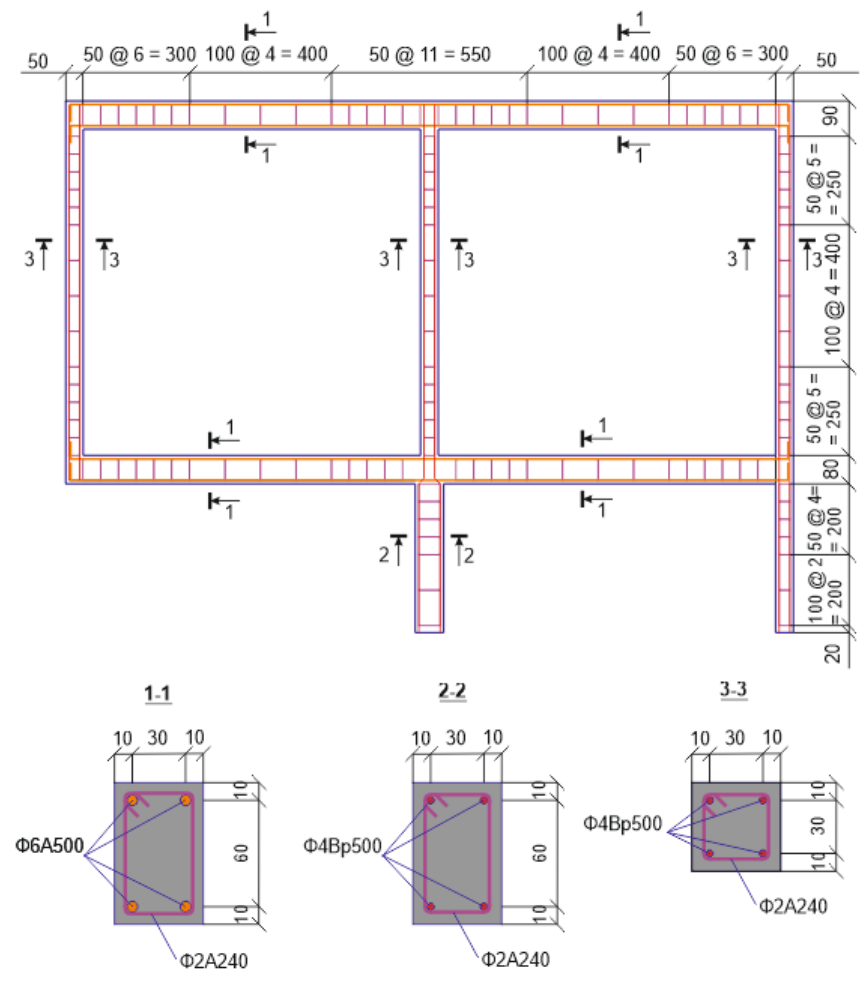
Figure 1. Design of the reinforced concrete test frame: the reinforcement. The scale of the experimental frame was assumed to be about one to eight with respect to a possible full-scale frame design. The slenderness ratio of columns in the plane